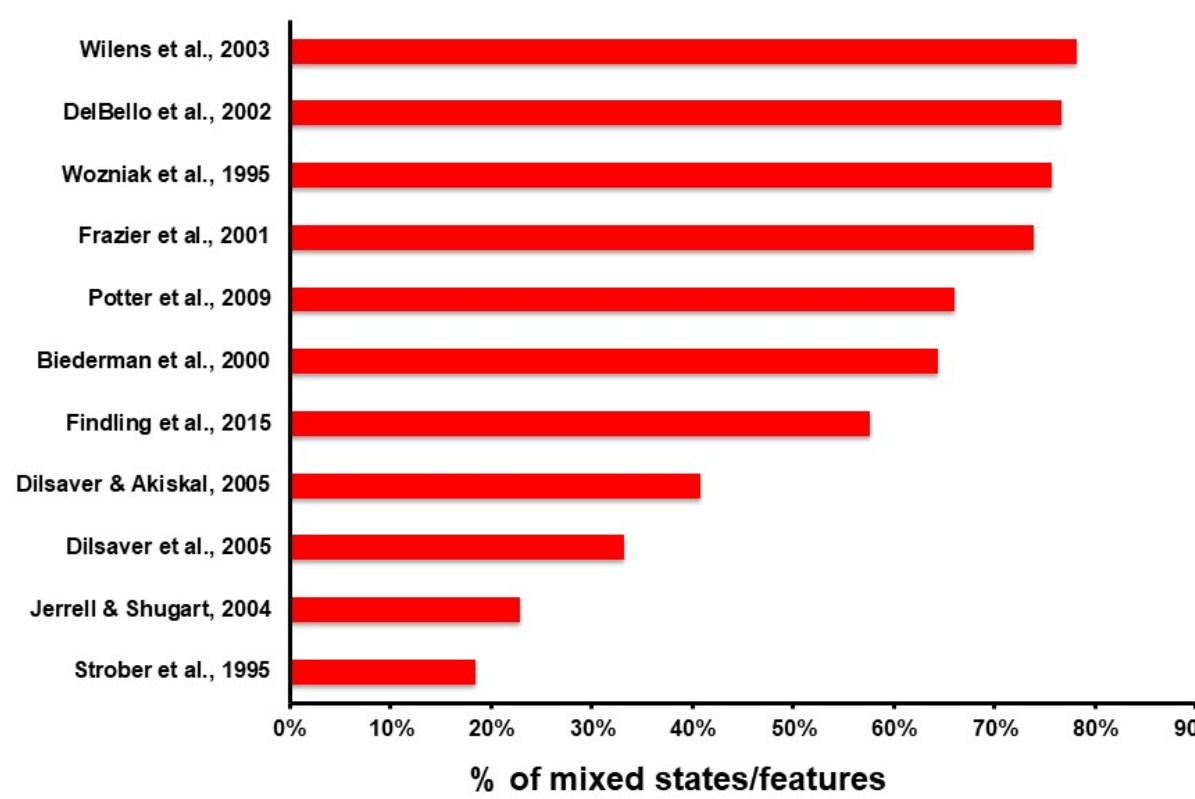
Figure 2. Prevalence rates of mixed features/mixed states in the included studies, from higher (top) to lower (bottom) [15,19–28].